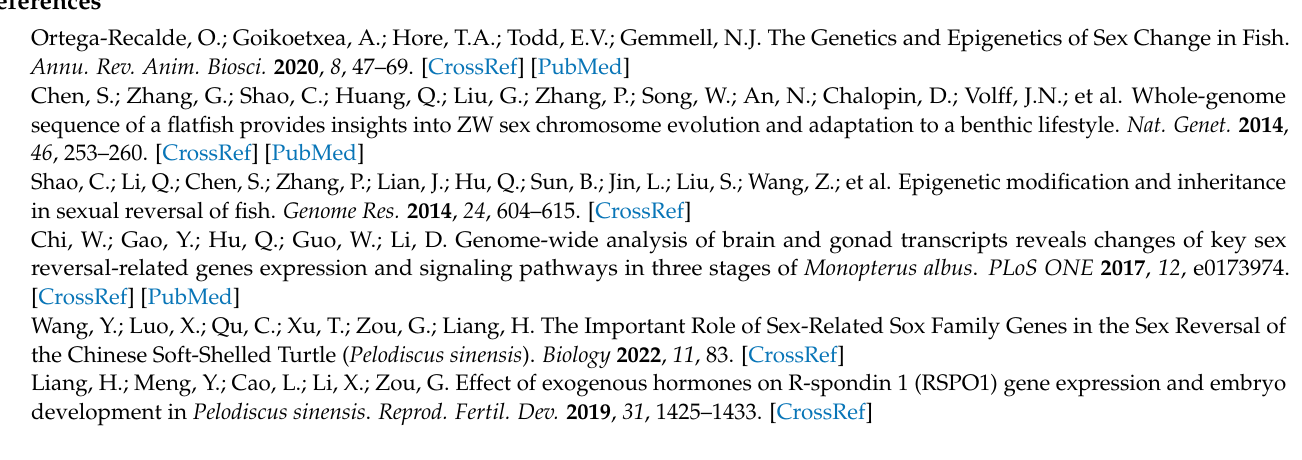
proteomics data of different samples. Figure S2: GO and KEGG enrichment analysis of labeled proteins. Figure S3: GO and KEGG enrichment analysis and subcellular location of abundant proteins in two comparison groups. Figure S4: Cluster analysis on the differentially expressed proteins among four types of Chinese soft-shelled turtles. Table S1: The primers used in this study. Table S2: Top 30 differentially expressed proteins between male and pseudo-female. Table S3. Top 30 differentially expressed proteins between female and